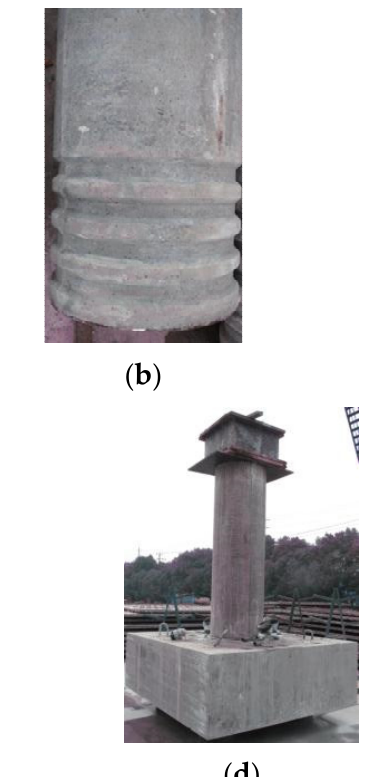
( b ) Figure 8. Loading device . ( a ) Loading schematic; ( b ) loading photo. 3.3. Test Results The specimen was subjected to axial compression loading. When the central com- pression axial pressure was loaded to 4500 kN, a micro-crack was found on the surface of the grouting material on the top surface of the bearing platform, and the crack width was 0.033 mm. When it was loaded to 10,000 kN, the maximum crack width of the grout was 0.08 mm. When the eccentric distance to the south side was changed to 5 cm, the bias loading was carried out. No cracks were found before the loading reached 3000 kN.